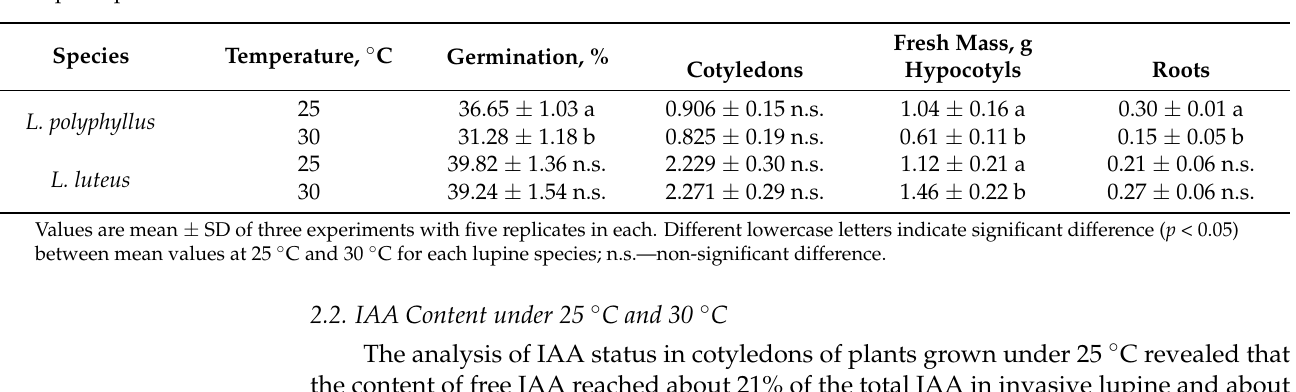
Figure 1. Four-day-old seedlings of non-invasive ( L. luteus ) (1) and invasive ( L. polyphyllus ) lupines (2) grown at 25 °C ( A ) and 30 °C ( B ). Scale bar, 1 cm. Table 1. Effect of temperatures of 25 °C and 30 °C on germination and growth parameters of four-day-old seedlings of two lupine species.